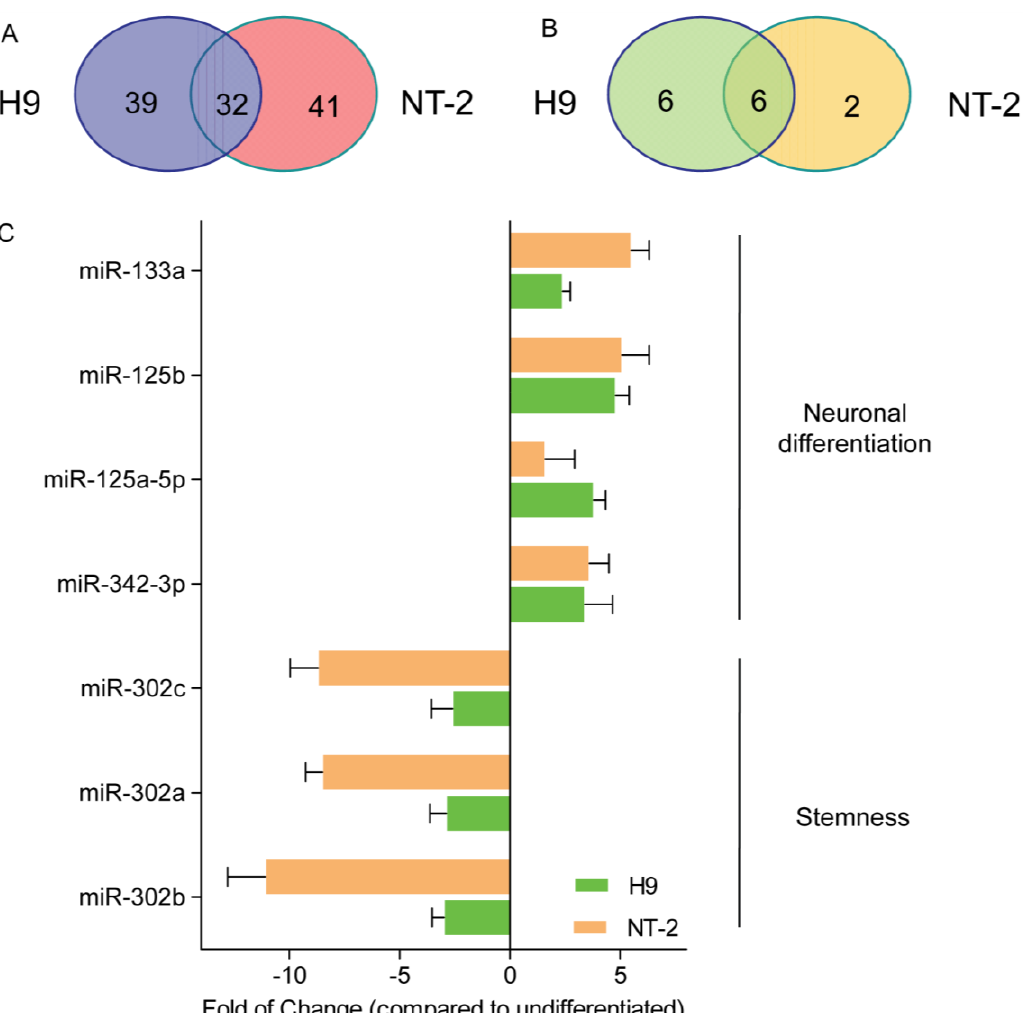
Figure 4. Comparison of miRNA expression level between H9 and NT-2 cell lines upon neuronal differentiation. miRNA expression overlapping between these two cell lines